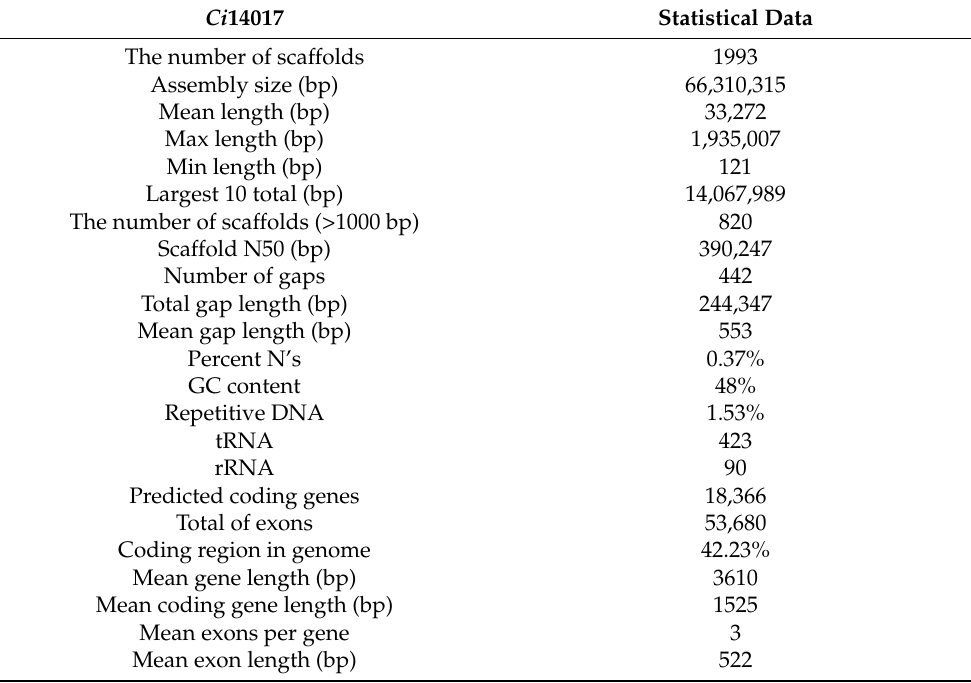
Table 1. Basic information of Ci 14017 whole